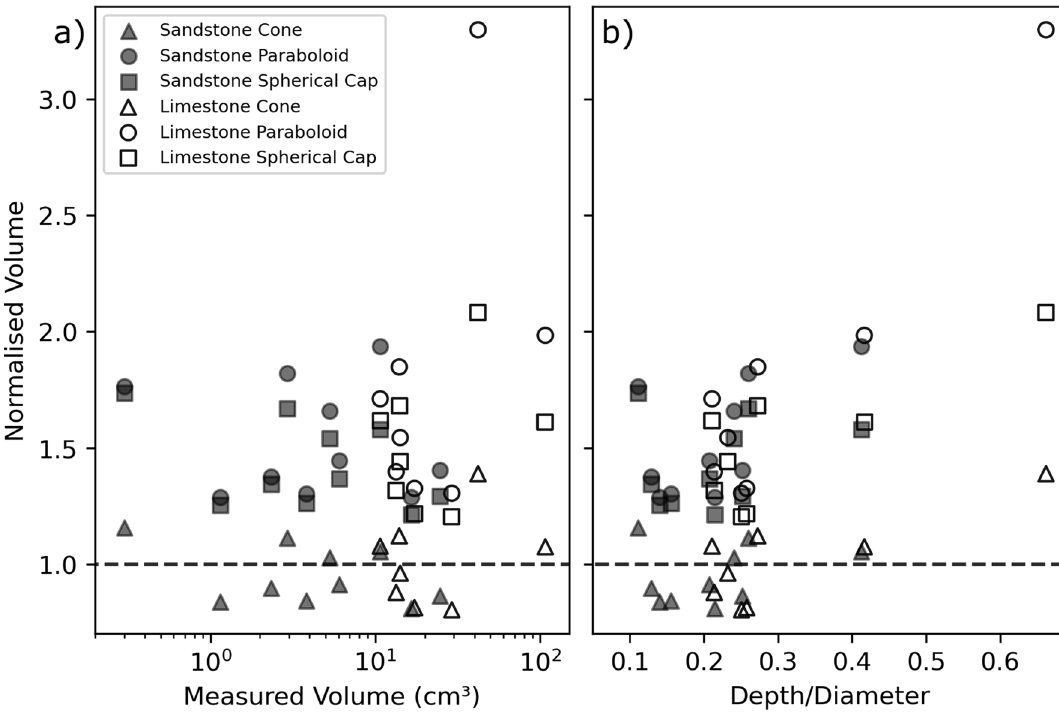
Figure 4. ( a ) Estimated crater volumes normalised to the crater volume measured from photogrammetry models plotted against photogrammetric volume. Sandstone targets (filled markers) have smaller crater volumes than limestone targets (hollow markers). The simple cone geometry (triangle marker) provides the closest estimate to the measured volume (dashed line). ( b ) Estimated crater volumes normalised to the crater volume measured from photogrammetry models plotted against depth/diameter ratio. There is a statistically significant, though weak, trend of increasing overestimation with increasing depth/diameter ratio (see Supplementary Table